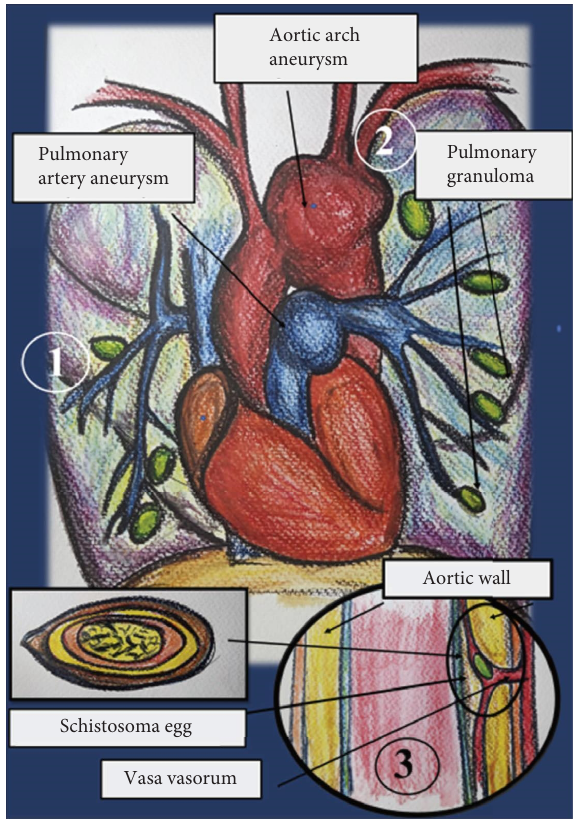
Figure 2: Aneurysms and schistosomiasis. Physiopathology behind aortic aneurysm and pulmonary artery aneurysm formation. (1) Schistosoma eggs may seed pulmonary arteries, leading to lung infammatory reaction and granuloma formation. Direct damage to vessels may occur as a result of infammation of tissues surrounding vessels. (2) Pulmonary infammation due to Schistosoma eggs seeding of pulmonary arteries may lead to pulmonary hyperten- sion. Damage to vessels may be due to hemodynamic changes. (3) Schistosoma eggs may seed major vessels wall through vasa vasorum, causing cystic medial necrosis and loss of wall integrity.